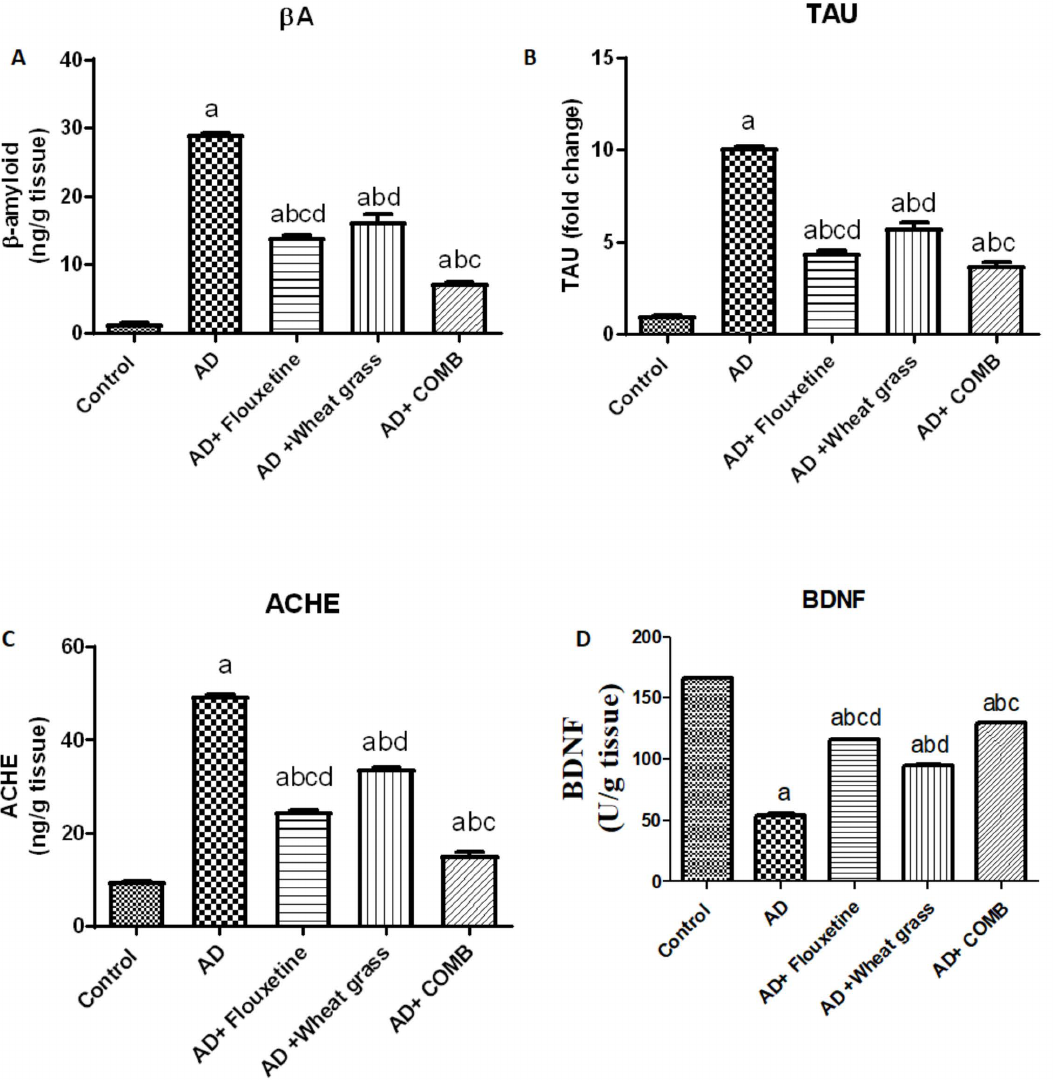
Figure 1. Effect of fluoxetine, wheatgrass, or their combination on cerebral A β ( A ), TAU ( B ), ACHE ( C ), and BDNF ( D ), Data were expressed as means ± SD. a, b, c, or d. Significantly different from the control, AD, wheatgrass/AD or combination/AD group, respectively, p < 0.05 using ANOVA followed by Tukey–Kramer as post hoc